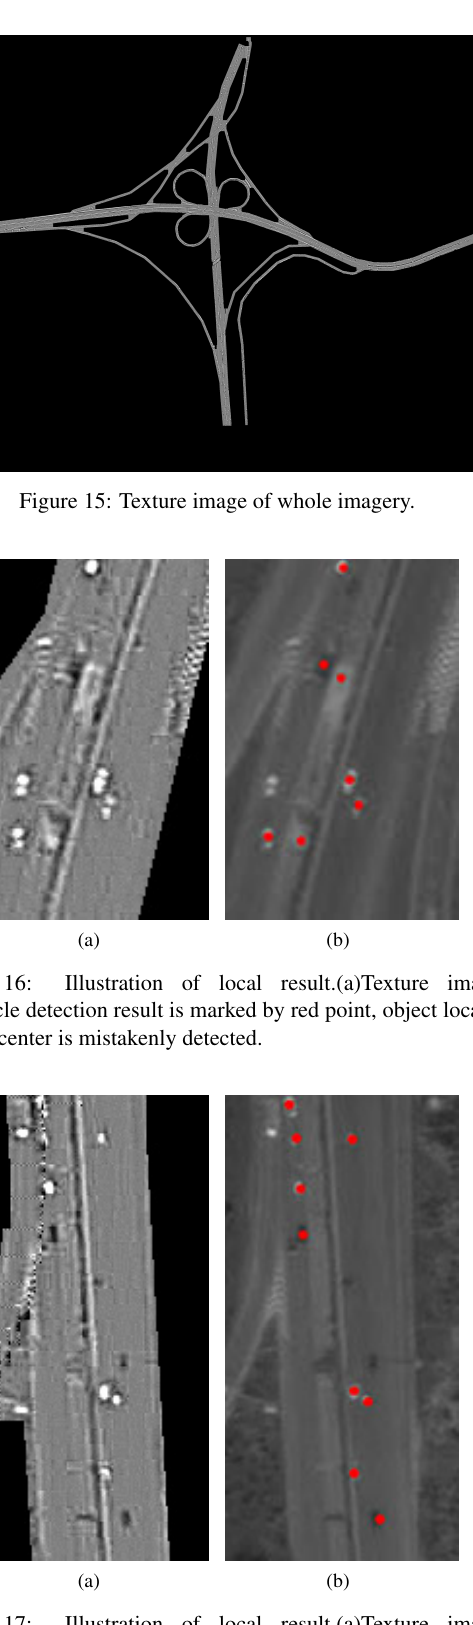
Figure 17: Illustration of local result.(a)Texture image. (b)Vehicle detection result is marked by red point, several black vehicles are not detected.